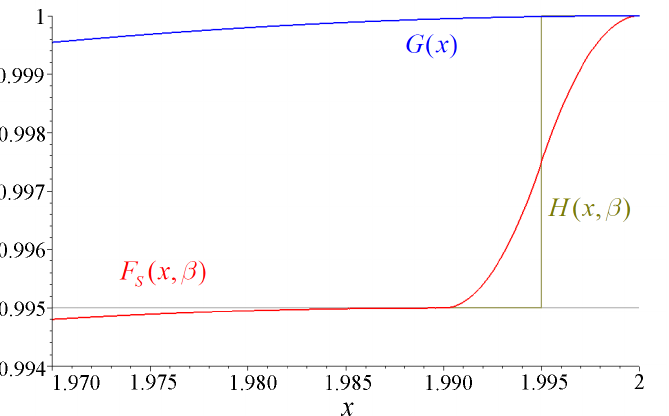
Figure 8: Plots of the cdf’s F S ( x , β ) , G ( x ) and H ( x , β ) for β = 0.005 in Example